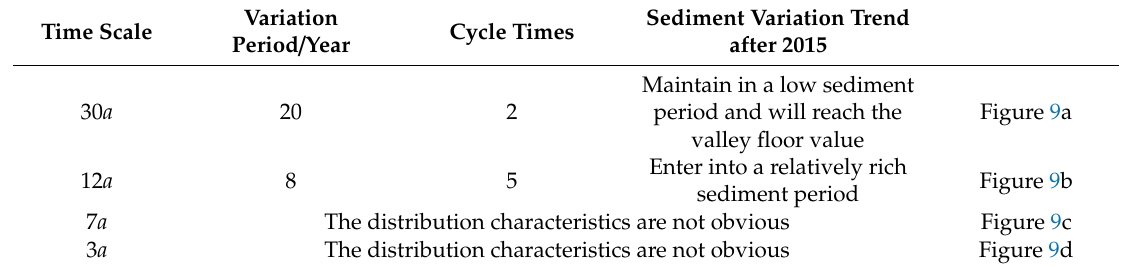
Table 4. Analysis results of sediment time series di ff erent characteristic time scales.